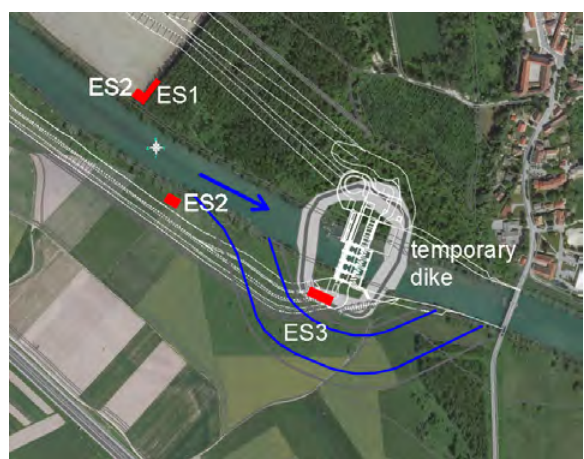
Figure 8. Location of the field trial tests: ES 1: roller compaction; ES 2: RIC; ES 3 and temporary dike: soil